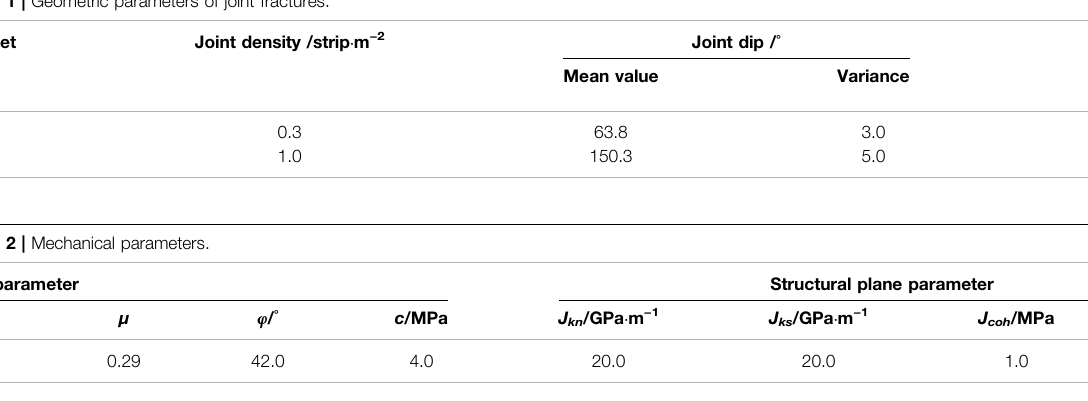
TABLE 1 | Geometric parameters of joint fractures.